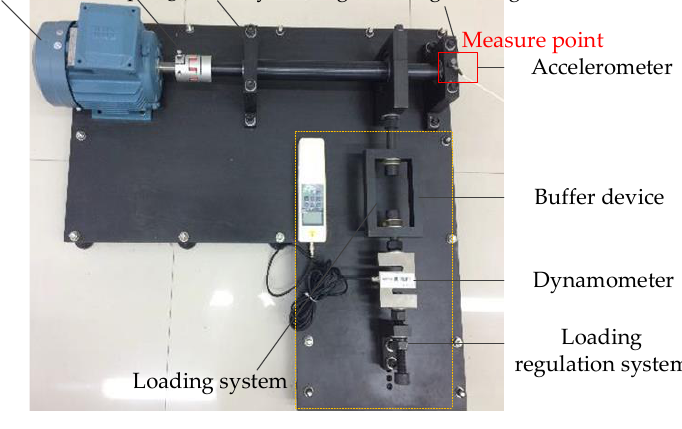
Appl. Sci. 2019 , 9 , x FOR PEER REVIEW